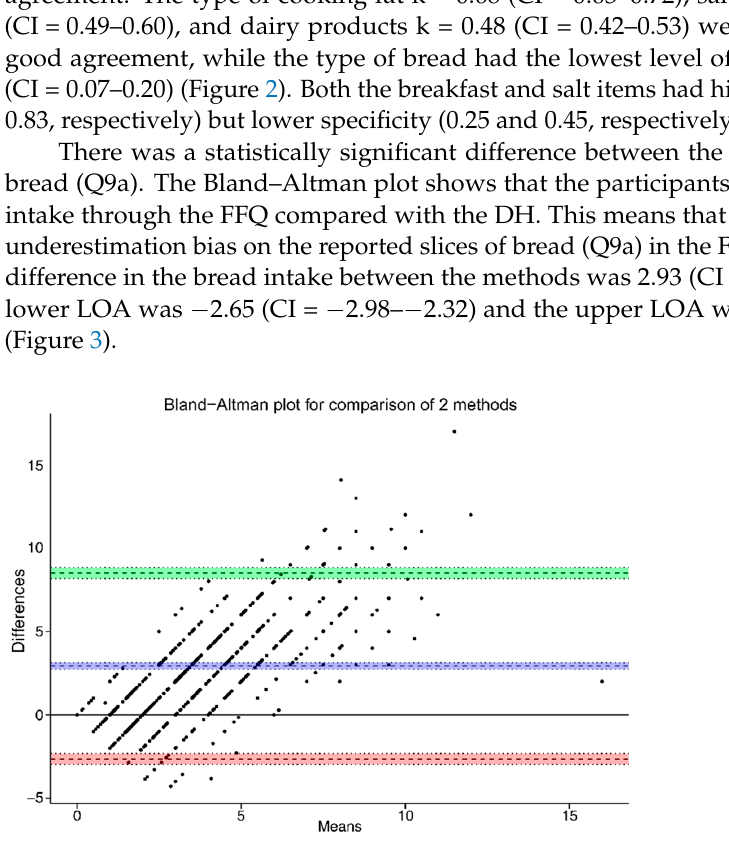
Figure 2. Proportion of agreement between methods for categorical items in the Food Frequency Questionnaire compared with Diet History, and respective weighted kappa values.